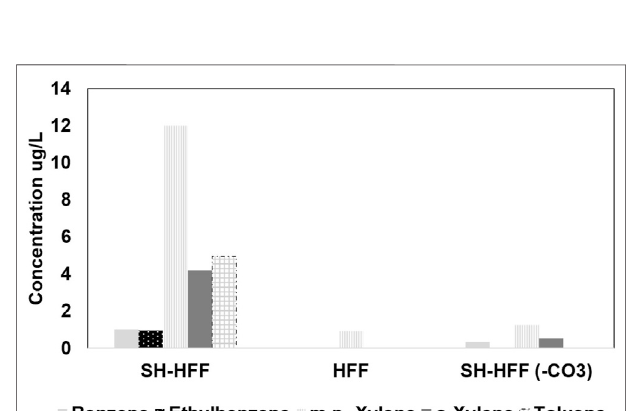
FIGURE 4 | BTEX in solution for each reaction by GC-MS.